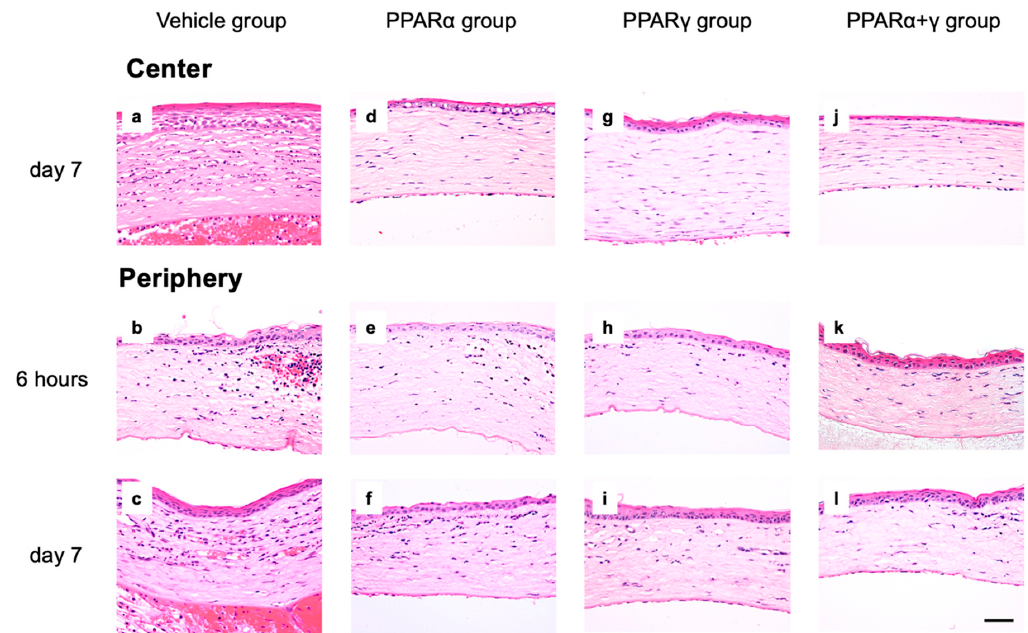
Figure 2. Histological analysis following hematoxylin and eosin (HE) staining. The central and peripheral cornea of the vehicle group ( a – c ), PPAR α group ( d – f ), PPAR γ group ( g – i ), and PPAR α + γ group ( j – l ) at 6 h and day 7. Bar, 50 μ m. Various inflammatory cells infiltrated from the peripheral